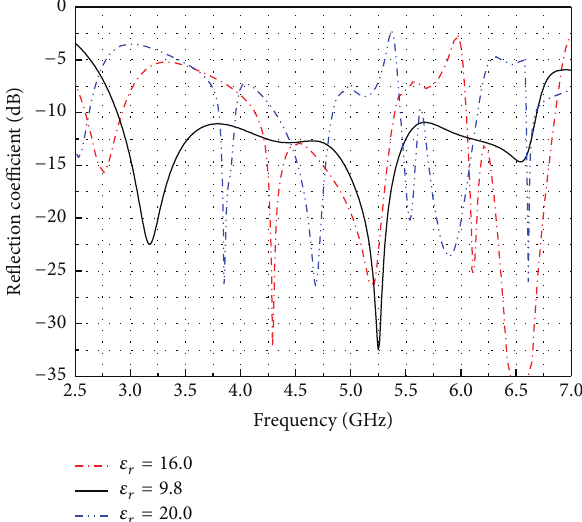
Figure 6: Simulated reflection coefficient with different values of 𝑑 = 23.0 mm, 𝑑 = 3.0 mm, ℎ = 6.0 mm, ℎ = 15.0 mm, 𝐿 1 ( 1 2 1 2 = 10.0 mm, 𝑊 = 13.0 mm, 𝑊 = 2.0 mm, and 𝐿 = 2.5 mm). ℎ 3 1 2 2